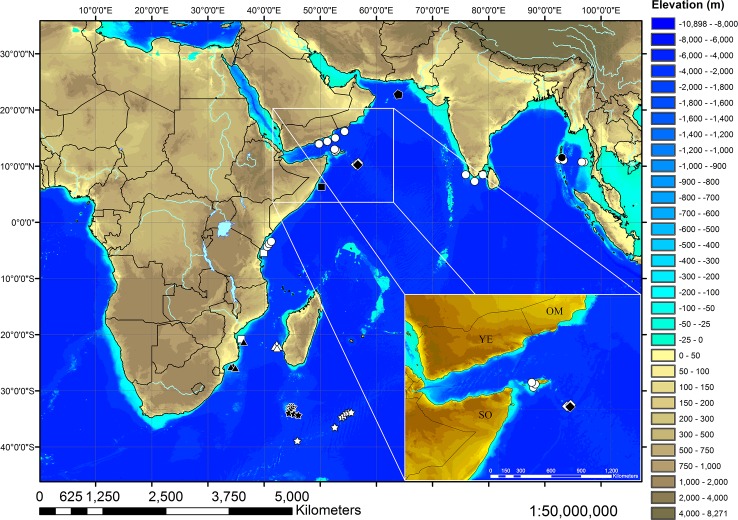
Map of the Indian Ocean depicting the verified occurrences of nine species of Bythaelurus in the Indian Ocean.The occurrences are based on examined material except for B. clevai (based on one examined specimen plus catch locations of the type specimens taken from Séret [12] and B. alcockii (no specimen available, catch location of the lost holotype indicated as Arabian Sea in Garman [40]). Bythaelurus alcockii: black pentagon, B. bachi: black stars, B. clevai: white triangles, B. hispidus: black (holotype) and white (other specimens) circles, B. lutarius: black triangles, B. naylori: white stars, B. stewarti n. sp.: black and white diamonds, B. tenuicephalus: white squares, B. vivaldii: black square. Inset of the Gulf of Aden area depicts the catch locations of the holotype (black diamond) and paratypes (black and white diamonds) of Bythaelurus stewarti n. sp. on Error Seamount and catch locations of 100 comparative specimens of B. hispidus from off the Socotra Islands (white circles). Country abbreviations follow ISO 3166–1 (OM = Oman, SO = Somalia, YE = Yemen).